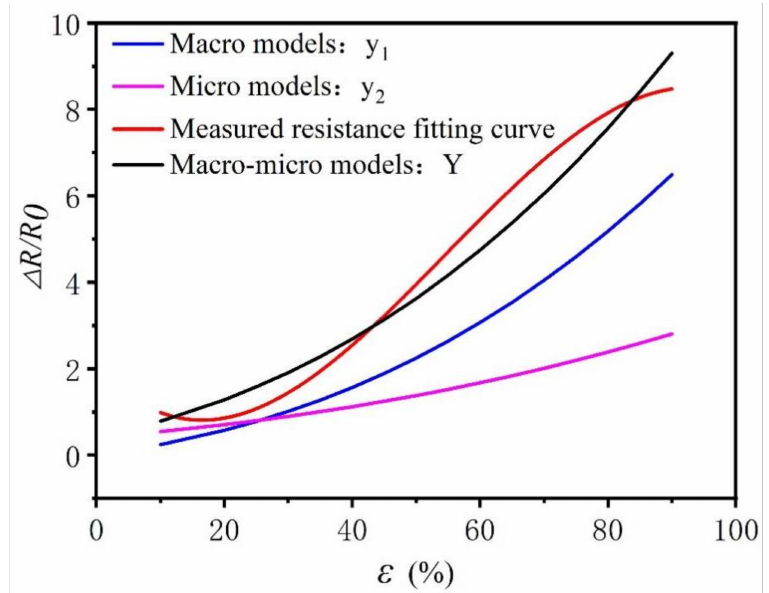
Figure 9. Comparison of the actual resistance and the in-plane tensile equivalent resistance model calculation results. Table 2. Parameter estimates for in-plane tensile equivalent resistance